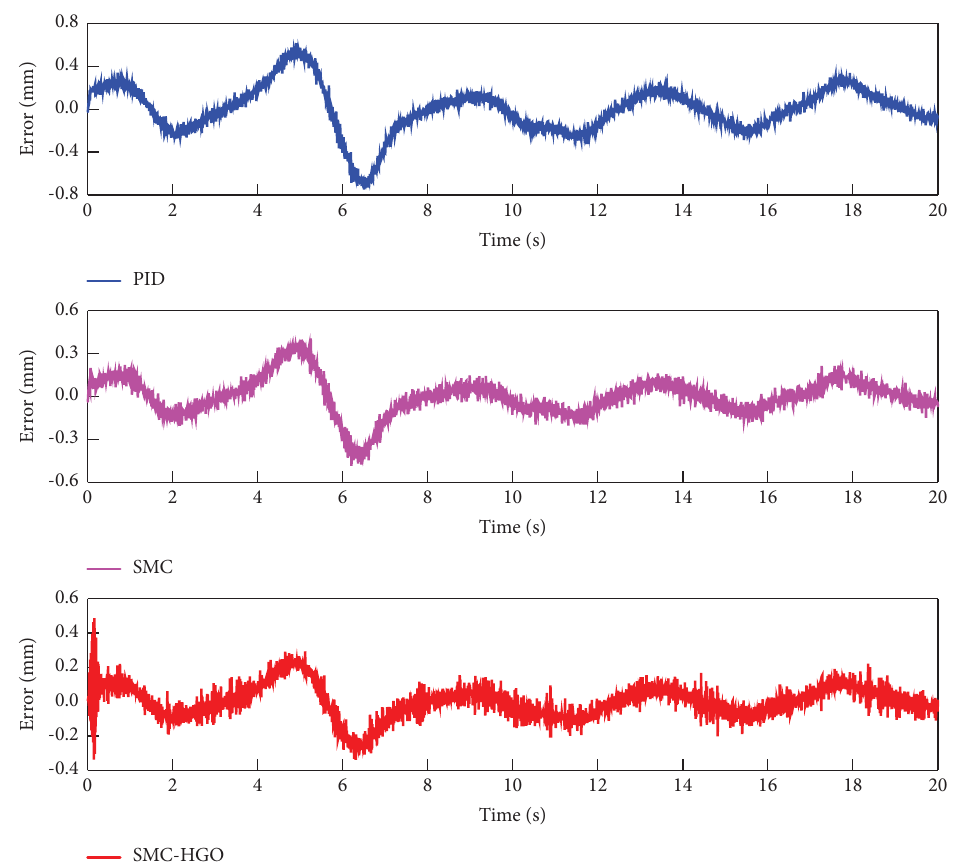
Figure 4: Comparative tracking errors of sinusoidal